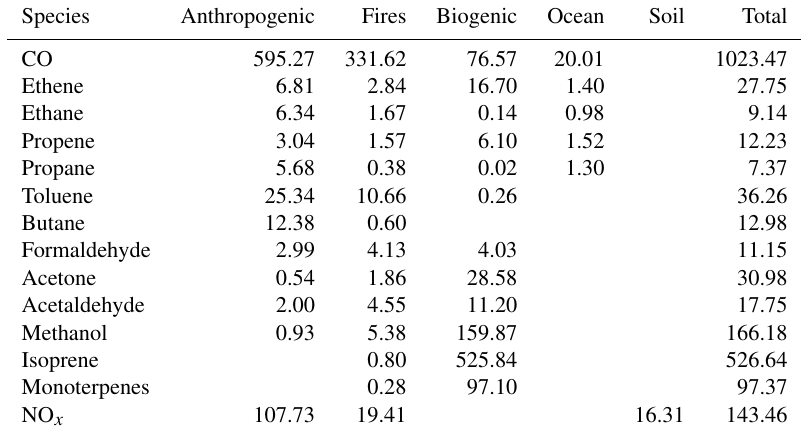
Table 1. TOMCAT annual global emissions used in the model simulations presented in this paper (Tg(species) year − 1